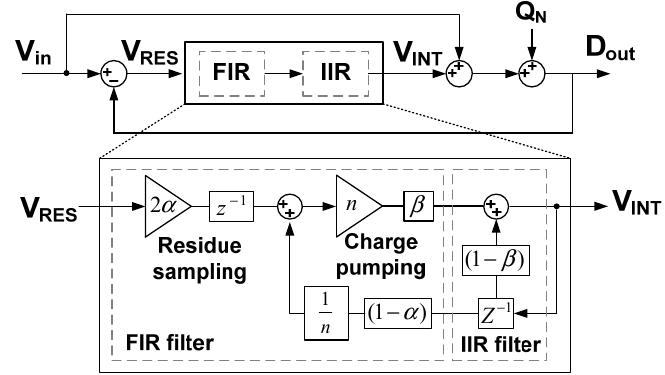
Figure 7. Behavioral model of the proposed ADC.